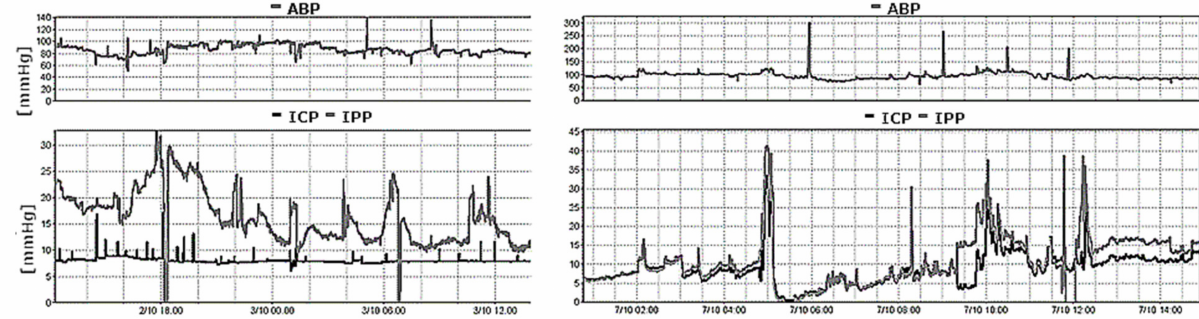
Figure 4. A recording of arterial blood pressure (ABP) and intraparenchymal pressure (IPP- bottom panel, grey line) together with EVD pressure (ICP- bottom panel, black line) using an external transducer in a patient after a poor-grade subarachnoid haemorrhage. The ( left panel) demonstrates the results with the drain opened, whereas the right panel demonstrates the results with the drain closed. With an open EVD, the two pressure readings failed to correlate. EVD pressure is held constant at a value representing the calibrated level of the drain above the heart. With a closed EVD ( right panel), the two measured pressure values correlate over time.